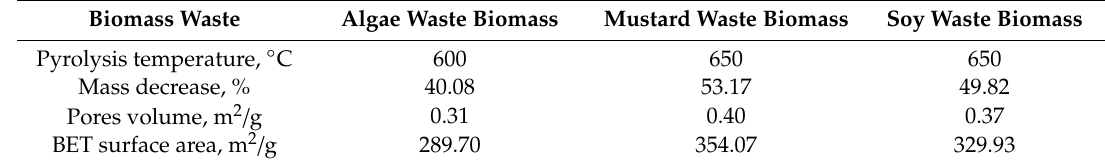
Table 1. Characteristics of pyrolysis process and porosity parameters of the obtained biochars. Biomass Waste Algae Waste